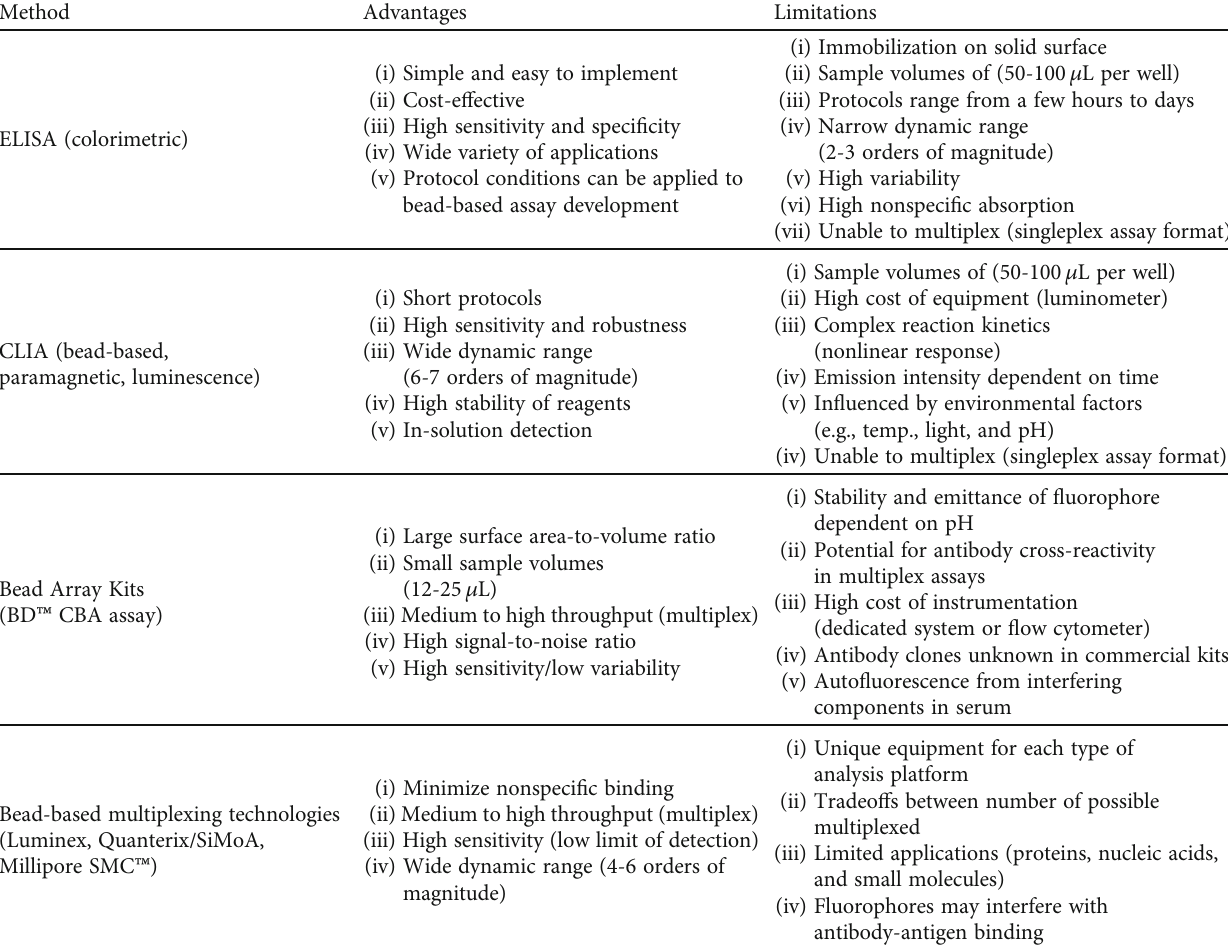
Table 1: Advantages and limitations of current immunoassay